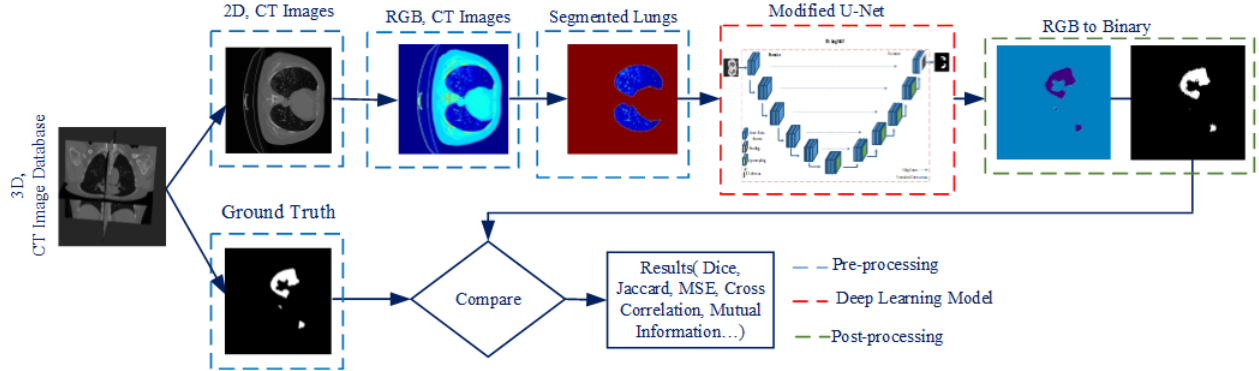
Fig. 1. Process of segmenting COVID-19 tissues from CT images,